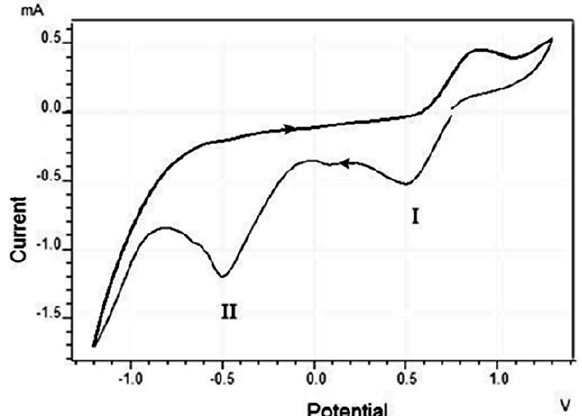
Fig. 2. The effect of temperature on the electroreduction of iron (III) ions. The electrolyte composition in (M): 0.1 Fe(NO 3 ) 3 · 9H 2 O + CH 2 OH-CH 2 OH; at different Т (К): 1- 288; 2- 298; 3- 308; 4- 318; 5- 328; 6- 338; 7- 348, and scan rate Е V = 0.02 V/s